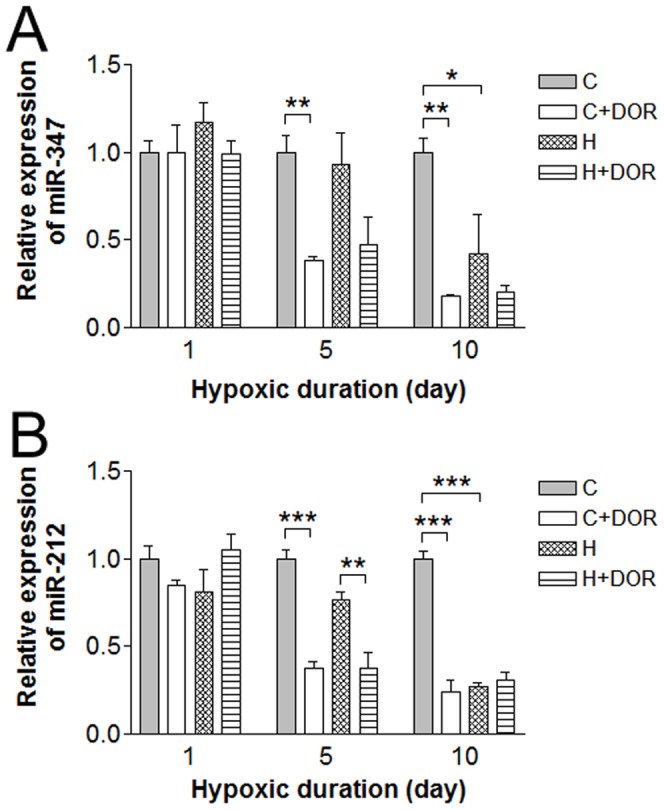
Relative miRNA expression levels of miR-347 and miR-212 in the kidney following either 1, 5, or 10 days of hypoxia as determined by quantitative RT-PCR.C, control; C+DOR, control+UFP-512; H, hypoxia; H+DOR, hypoxia+UFP-512. *p<0.05, **p<0.01, ***p<0.001.